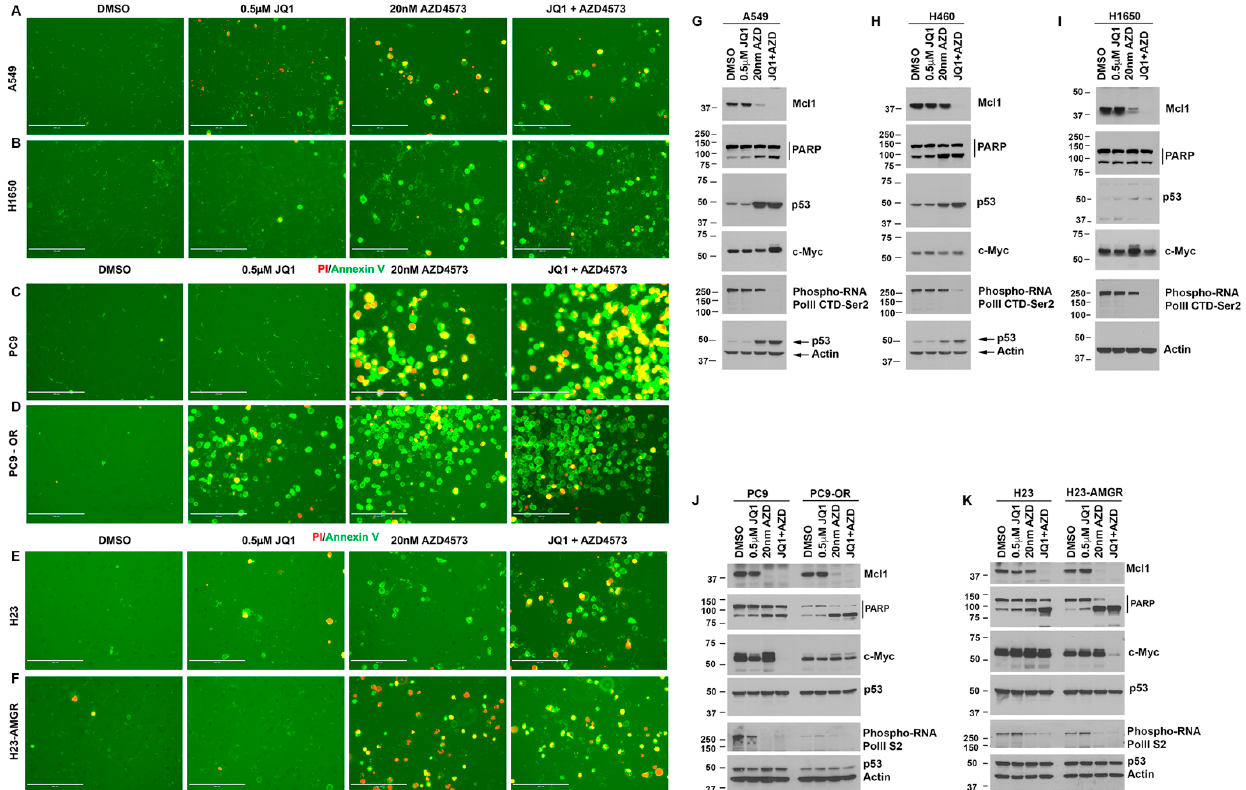
Figure 6. Lung cancer cells treated with AZD4573 and JQ1 show enhanced apoptosis and inhibition of Mcl1: ( A – F ) A549 ( A ), H1650 ( B ), PC9 ( C ), PC9-OR ( D ), H23 ( E ), and H23-AMGR ( F ) cells were treated with JQ1, AZD4573, or a combination of both, and stained using Annexin V (green) and PI (red) to determine apoptosis induction. ( G – I ) Western blot analysis on A549 ( G ), H460 ( H ), or H1650 ( I ) cells treated with AZD4573, or JQ1 alone, or in combination were analyzed for alterations in Mcl1, PARP, p53, c-Myc or RNA Pol II CTD phosphorylation. Actin was used to re-probe the blots for protein normalization. ( J , K ) PC9 cells, sensitive or resistant to osimertinib, and H23 cells sensitive or resistant to AMG510, were treated with JQ1, AZD4573, or their combinations and analyzed with same antibodies as in the case of ( G – I ). Results show complete inhibition of Mcl1 and increased PARP cleavage in response to co-treatment with AZD4573 and JQ1.